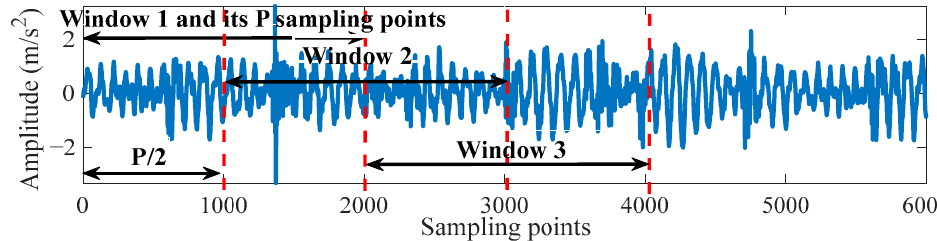
Figure 1. The schematic diagram of sliding window and down − sampling. (2) In order to improve the characterization performance of DE, the down-sampling signal are mapped to different categories by introducing TANSIG mapping, and it is used as the SDE k feature of the k -th time point signal. Its calculation is summarized as follows. Step 1: Map the signal x j ( j = 1, 2, · · · , N ) to c categories. Different from DE, the NCDF function of DE is replaced by the tan-sigmoid mapping function (TANSIG), after which the original signal x j is mapped to the range between 0 and 1, i.e., y = { y 1 , y 2 , · · · , y N } , y